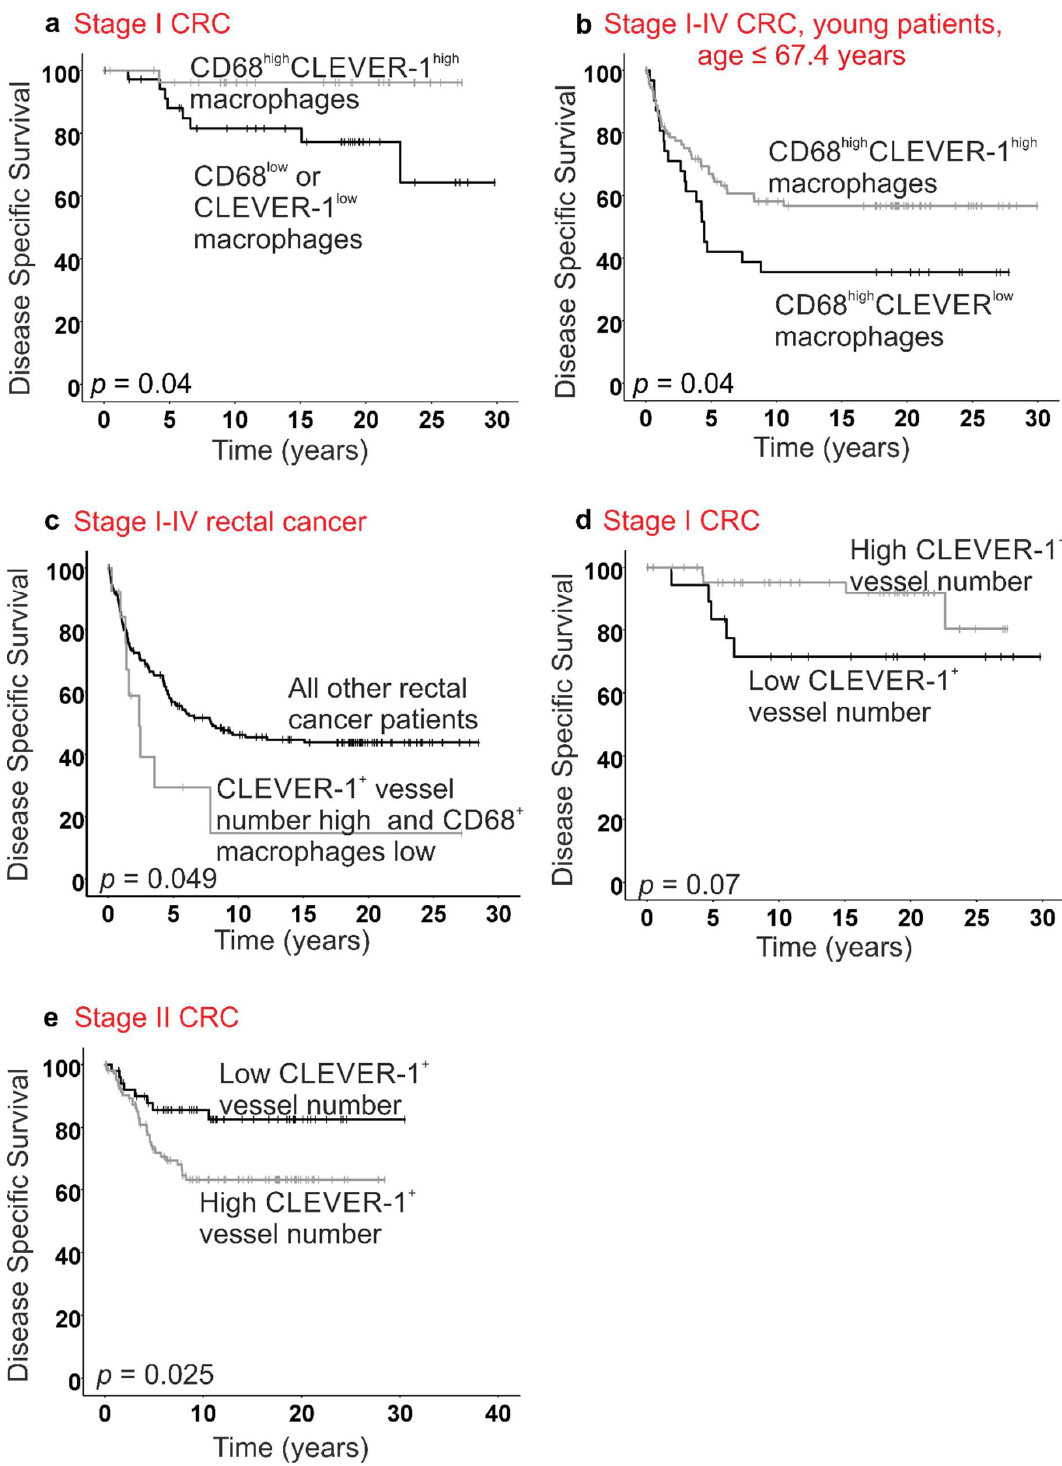
Figure 5. Kaplan-Meier survival curves of disease-specific survival (DSS) in colorectal cancer (CRC) patients. ( a ) In stage I CRC, high number of both CD68 + and CLEVER-1 + macrophages was associated with improved DSS. ( b ) In young patients (age below median, ≤ 67.4 years) with a high CD68 + macrophage density, a low CLEVER-1 + macrophage number was associated with poor outcomes. ( c ) A high density of CLEVER-1 + lymphatic vessels together with a low number of CD68 + macrophages was associated with poor survival in rectal cancer. ( d ) In stage I CRC a high number of CLEVER-1 + lymphatic vessels was a sign of good prognosis, which was opposite to stage II CRC ( e ), where a high CLEVER-1 + LVD was associated with poor